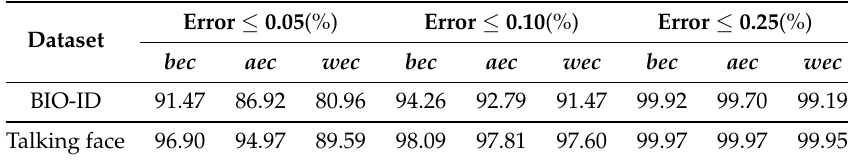
Table 4. Performance of the proposed iris center localization method on the BIO-ID and Talking Facedatabases.